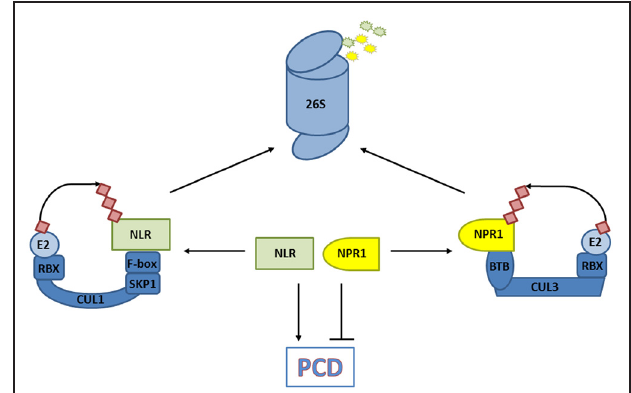
FIGURE 4 | CRLs decide on cell fate. The degradation of substrates that promote programmed cell death (PCD) in response to a pathogen [e.g., nucleotide-binding/leucine-rich repeat domain containing (NLR) immune receptors], and those that prevent PCD (e.g., non-expresser of PR genes, NPR1) are controlled by CRLs. The balance of substrate abundance between promoters and suppressors of PCD dictates cell fate, and is regulated by their ubiquitination and 26S proteasome-mediated